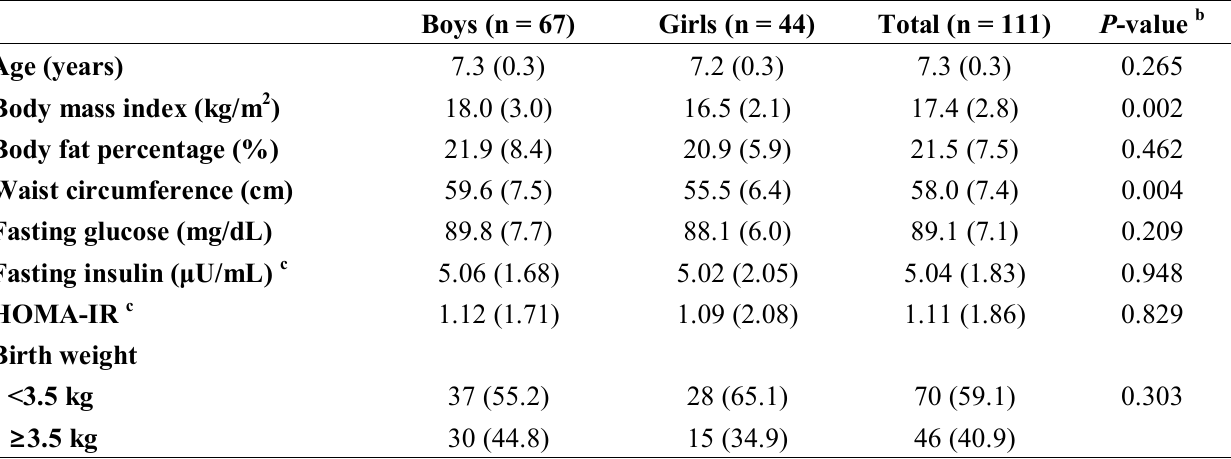
Table 1. General characteristics of children.